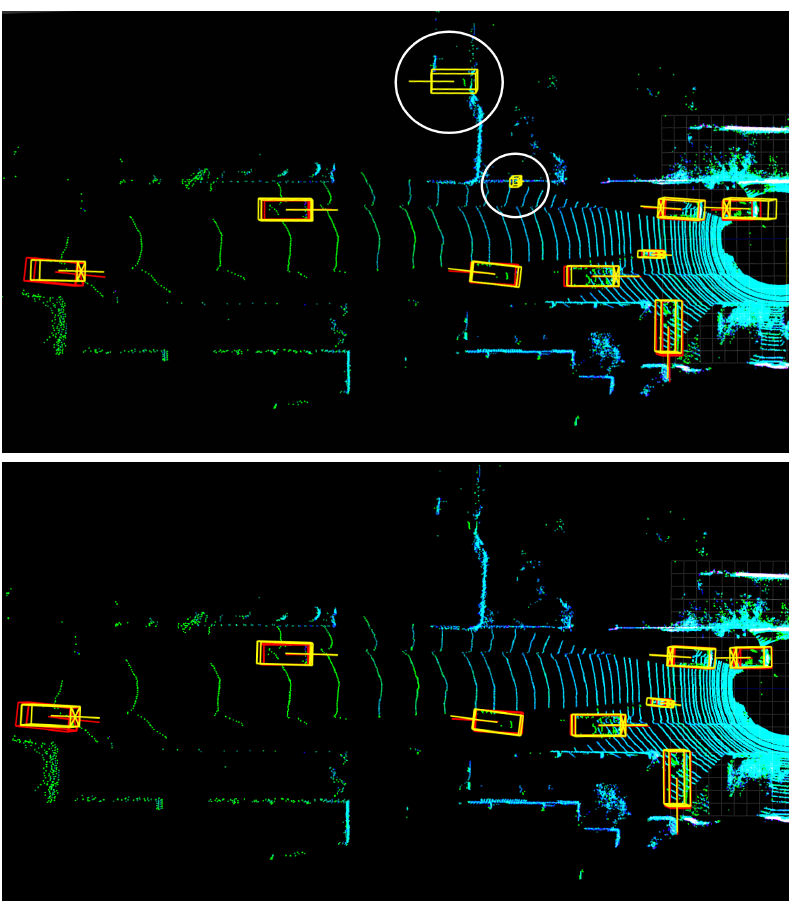
Figure 5. Comparison between 3DSSD and SGSSD on the KITTI validation set. The first and second lines are the detection results of 3DSSD and SGSSD, respectively. The red box represents the ground truth. The yellow box indicates the test results. White circles indicate false positive results.